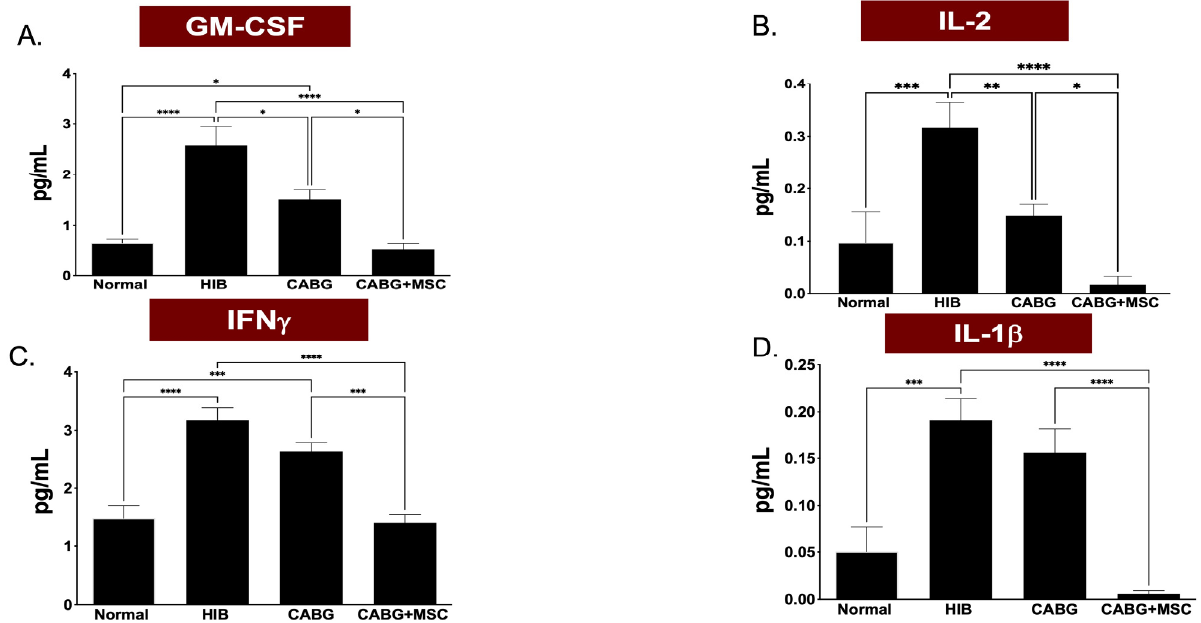
Figure 4. A multiplex cytokine and chemokine array analyses of GM-CSF, IFN γ , IL-2, and IL-1 β isolated from porcine LAD tissue regions in the Control, HIB, CABG, and CABG + MSC groups (n = 5/group). ( A ) GM-CSF expression showed a significant increase in HIB compared to the control group (**** p < 0.0001), with a significant decrease in CABG + MSC when compared to the HIB group (**** p < 0.0001). ( B ) IL-2 expression showed a significant increase in HIB compared to the control group (*** p < 0.001), with a significant decrease in CABG + MSC when compared to the HIB group (**** p < 0.0001). ( C ) IFN γ expression showed a significant increase in HIB compared to the control group (**** p < 0.0001), with a significant decrease in CABG + MSC when compared to the HIB group (**** p < 0.0001). ( D ) IL-1 β expression showed a significant increase in HIB compared to the control group (*** p < 0.001), with a significant decrease in CABG + MSC when compared to the HIB group (**** p < 0.0001). One-way analysis of variance (ANOVA), followed by Tukey’s post hoc test, was used for analyses. Data are presented as the means ± SEM. * p < 0.05; ** p < 0.01, *** p < 0.001, **** p < 0.0001. CABG = Coronary artery bypass graft, GM-CSF = Granulocyte-Macrophage Colony-Stimulating Factor, HIB = Hibernating myocardium, IFN γ = Interferon gamma, IL-2 = Interleukin 2, IL-1 β = Interleukin 1 beta, MSC = Mesenchymal Stem Cells.